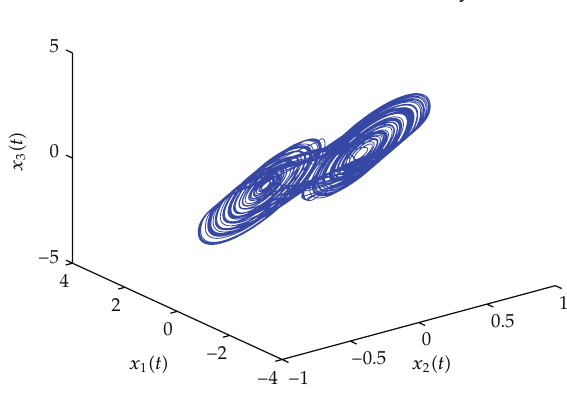
Figure 1: Chua’s circuit with x i (cid:6) 0 (cid:7) (cid:8) 0 . 1, for i (cid:8) 1 , 2 ,